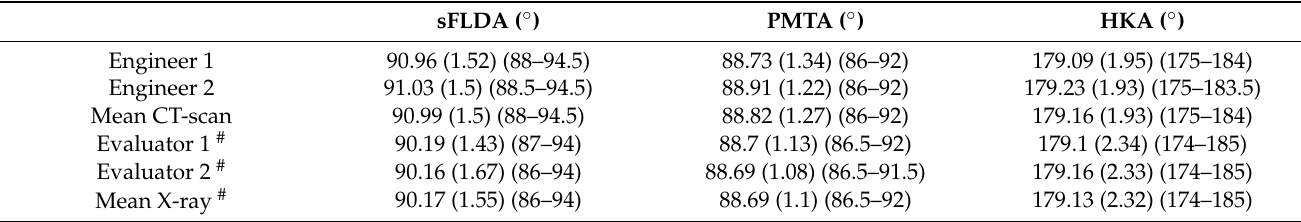
# The results shown correspond to the evaluators’ first radiographic measurements. There were no statistically significant differences between their two separate measurements in time, and both evaluators showed perfect intra-observer reliability in all angular values (ICC (2,1) between 0.953 and 0.995). We also found no difference between the measurements of both X-ray evaluators ( p = 0.939 for sFLDA, p = 0.957 for PMTA and p = 0.877 for HKA) and a perfect inter-observer reliability: ICC (2,1) = 0.974 (CI95%: 0.949 to 0.987) for sFLDA, 0.945 (CI95%: 0.849 to